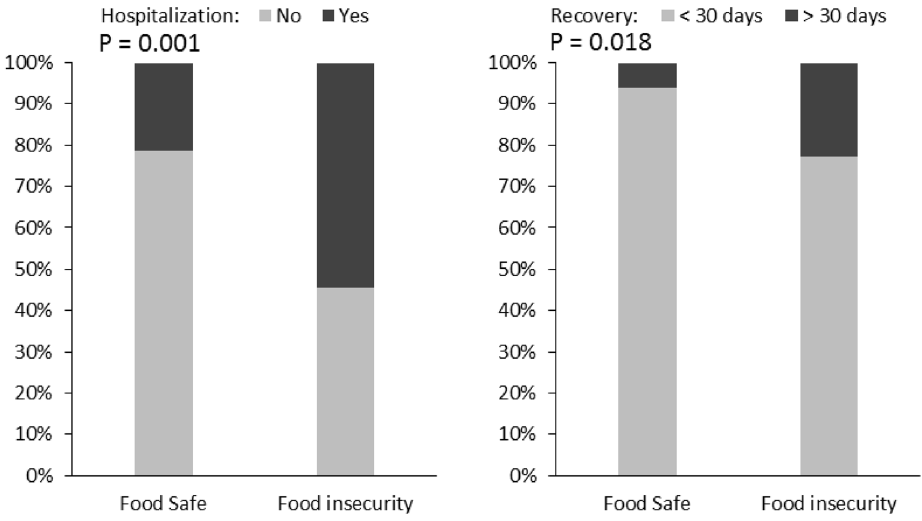
Figure 1. Hospitalization and recovery in the study